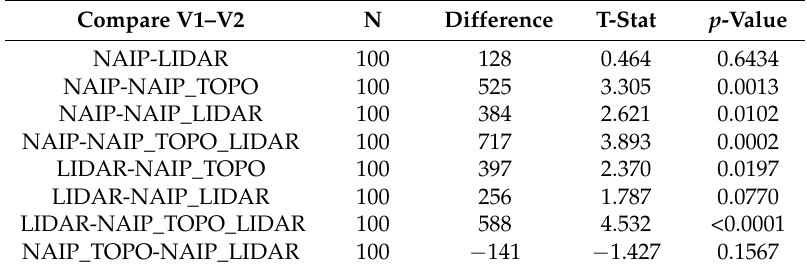
Table A5. TPH paired comparisons between models developed from combinations of NAIP, LiDAR and Topo data